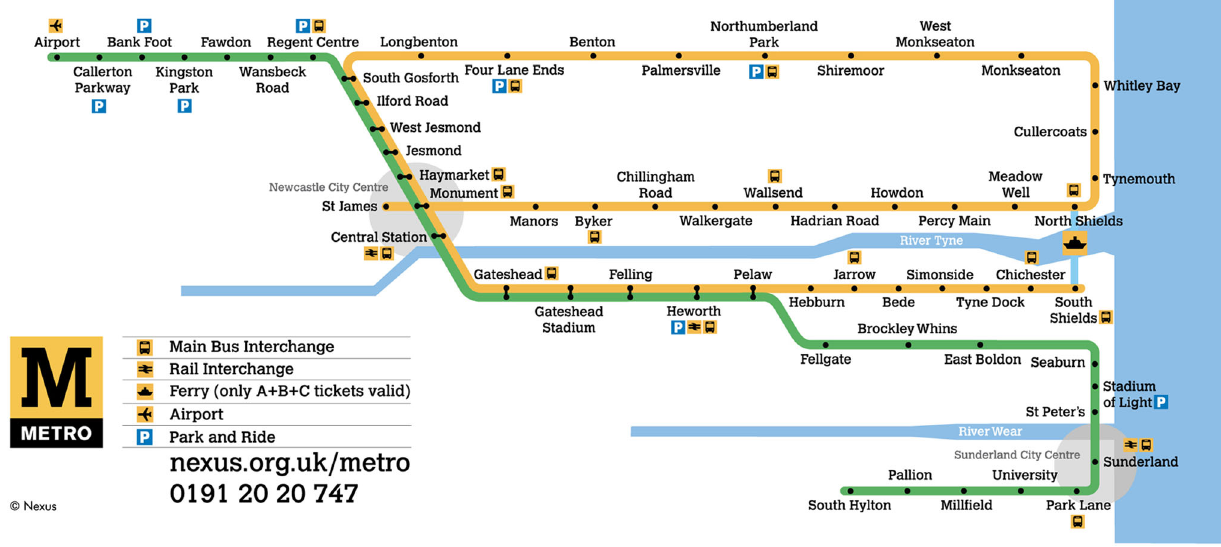
Fig. 1 Illustration of the layout of the Tyne and Wear Metro operating network Source :